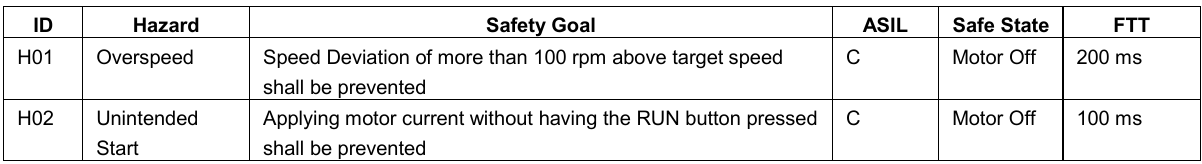
Table 4. Some Sample Hazards of the E-Drive System